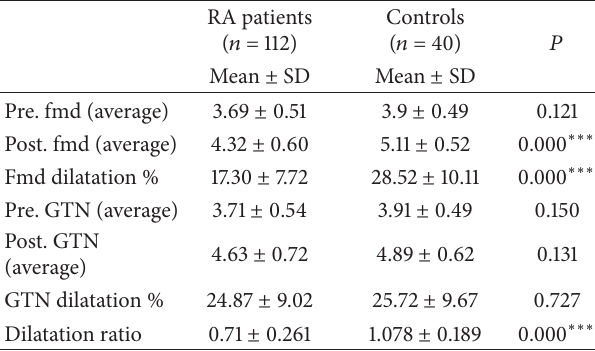
Table 8: Comparison of endothelial function in RA patients and controls.